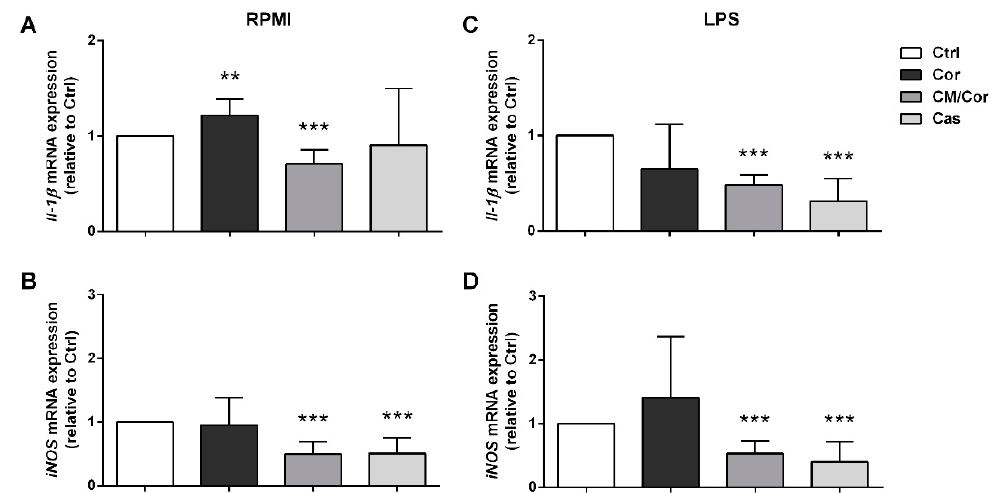
Figure 4. EVOO extracts differently modulate the expression of proinflammatory genes in BMDCs from wild-type mice based on their chemical composition. The expression levels of Il-1 β and iNOS were measured at basal conditions (RPMI, ( A , B )) and 6 h after LPS stimulation ( C , D ) in untreated (Ctrl) and treated BMDCs with different EVOO extracts (12.5 µg/mL) by real-time PCR. The bars represent the mean fold change ± SEM relative to Ctrl sample with or without LPS stimulation ( n = 3). ** p < 0.001, *** p < 0.0001 .